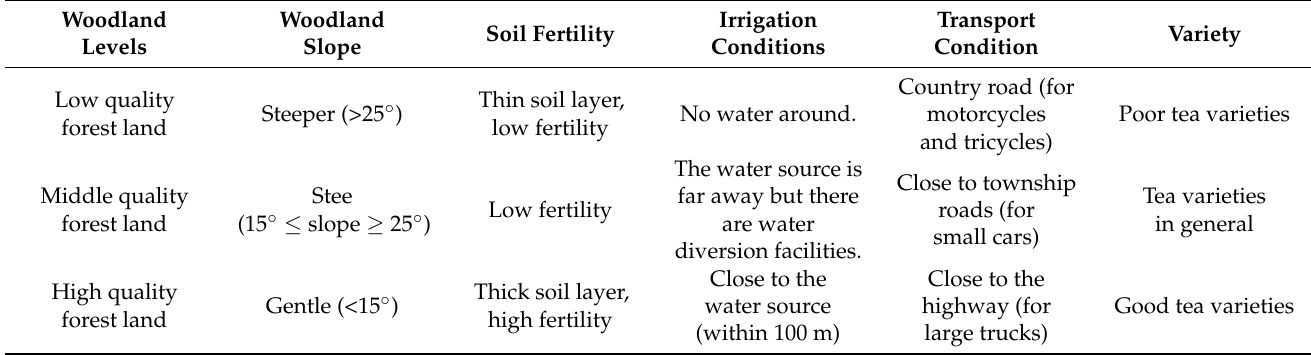
Table 1. Classification of forest quality